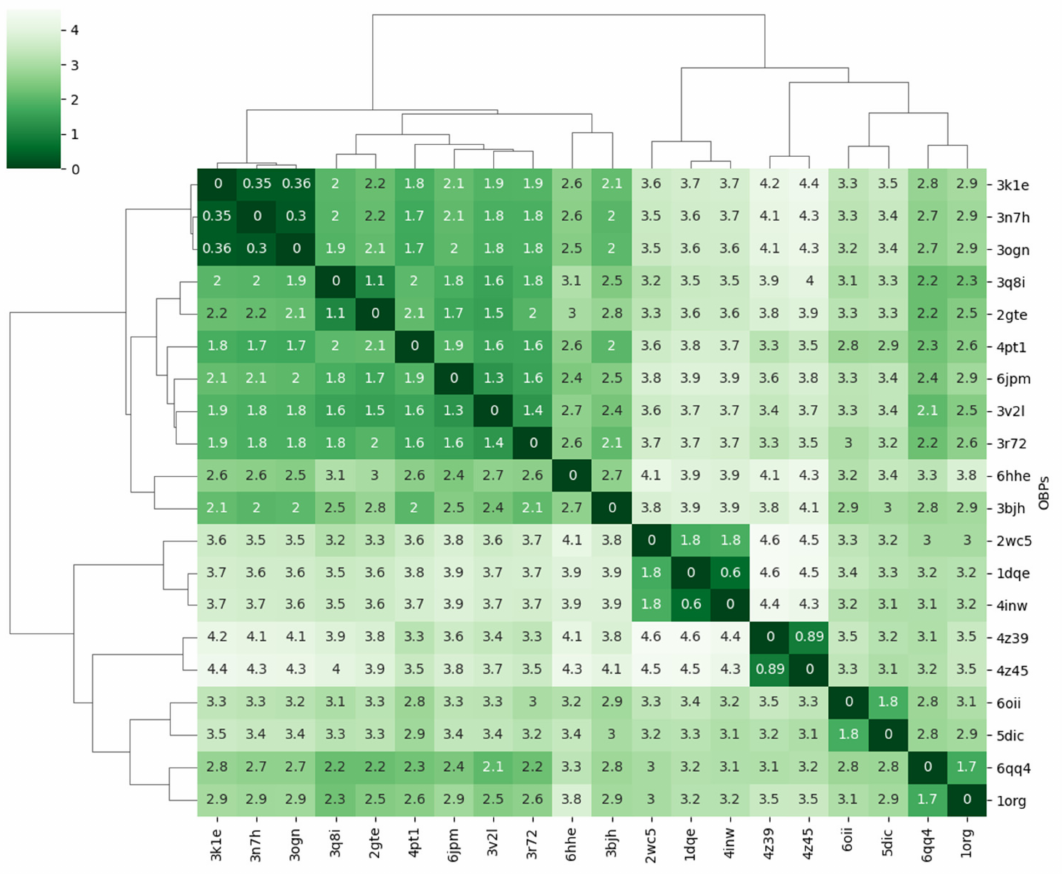
Figure 2. Pairwise similarity matrix of RMSD of equivalent C α atoms in the MSA. Comparisons of a protein to itself are shown along the diagonal. The values are in Å. The dendrogram shows the hierarchical clustering obtained from the complete linkage algorithm as implemented in the Python package